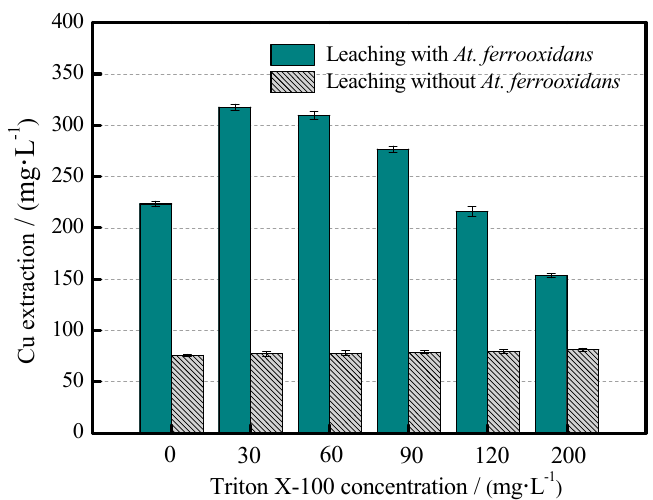
Figure 4. Influences of Triton X-100 on Cu extraction from chalcopyrite in the absence and presence of bacteria. Chalcopyrite 1% ( w / v ), bacteria inoculation 2 × 10 7 cells·mL − 1 for bioleaching systems, NaF 0.1 g·L − 1 for abiotic leaching systems, initial Fe 2+ 0 g·L − 1 , initial pH 2.0, and leaching for 24 days.